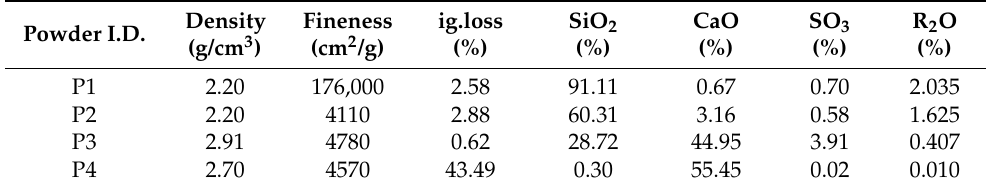
Table 2. Properties of powder materials. Powder I.D.